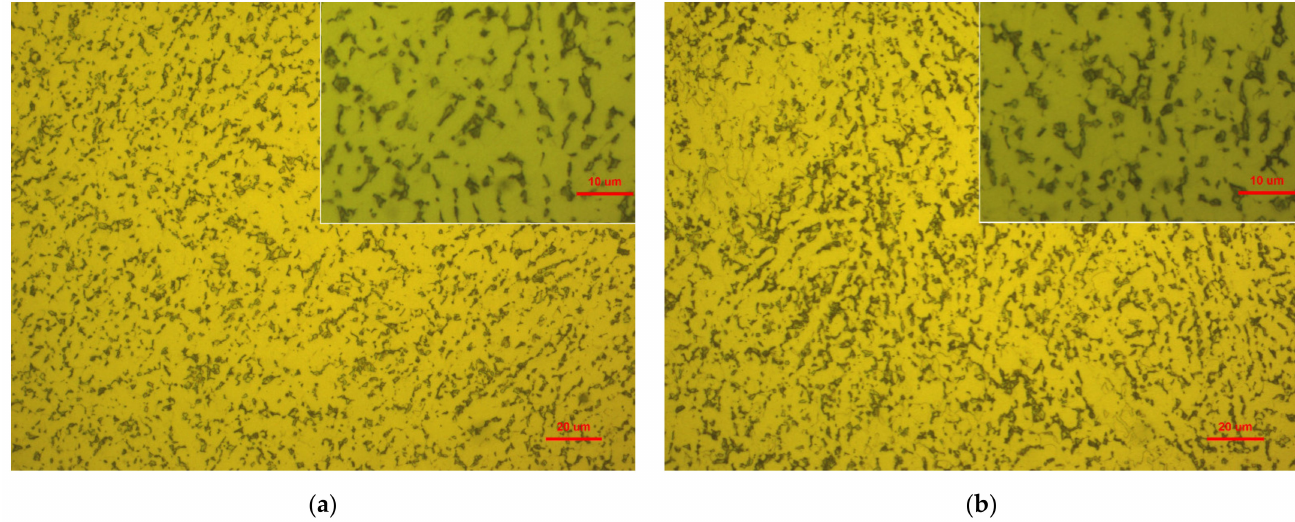
Figure 9. Metallographic structure of Ti-6Al-4V before and after polishing. ( a ) Before polishing. ( b ) After polishing. In order to clarify the difference of surface micro morphology of Ti-6Al-4V before